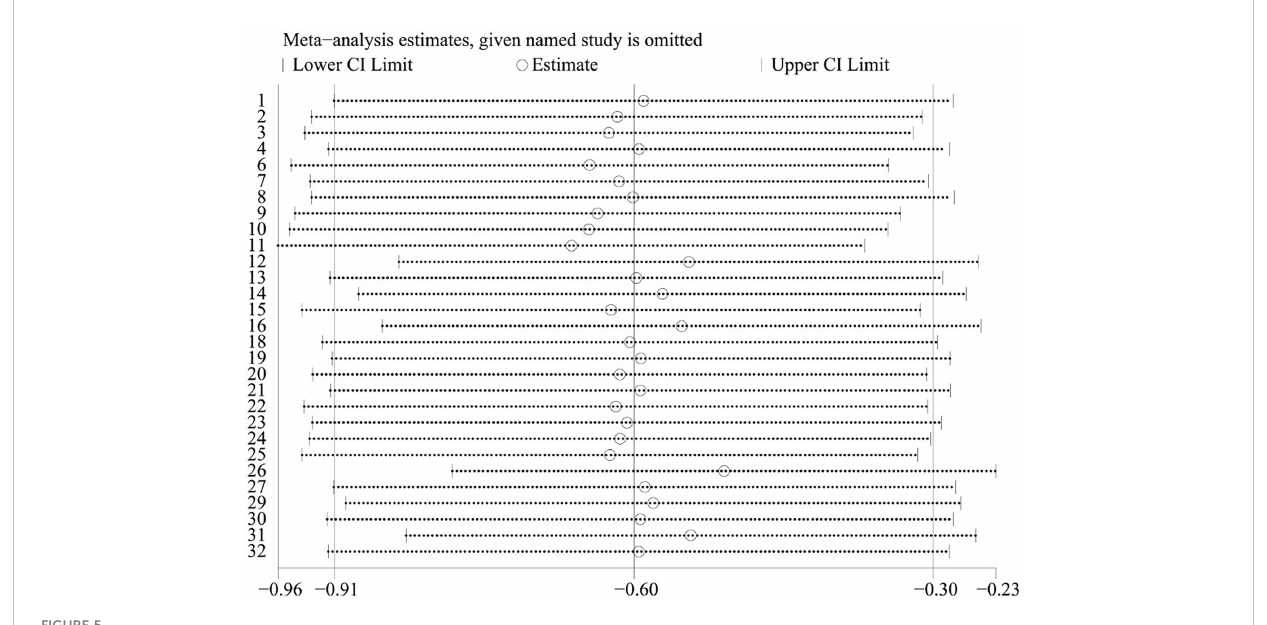
FIGURE 5 Sensitivity analysis for the network meta-analysis of